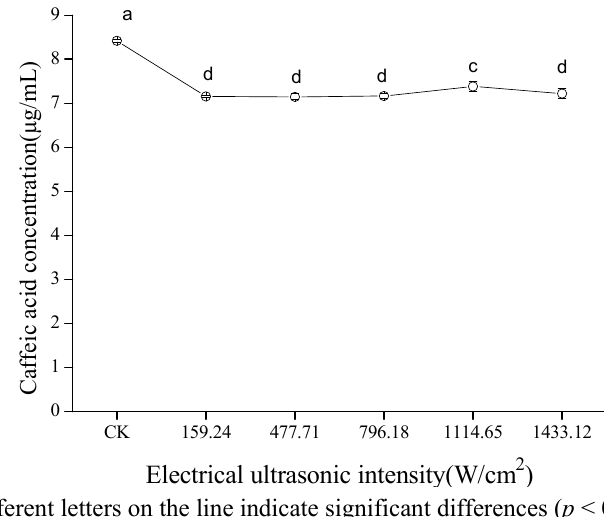
Figure 4. Effect of electrical ultrasonic intensity on the stability of caffeic acid under ultrasound treatment